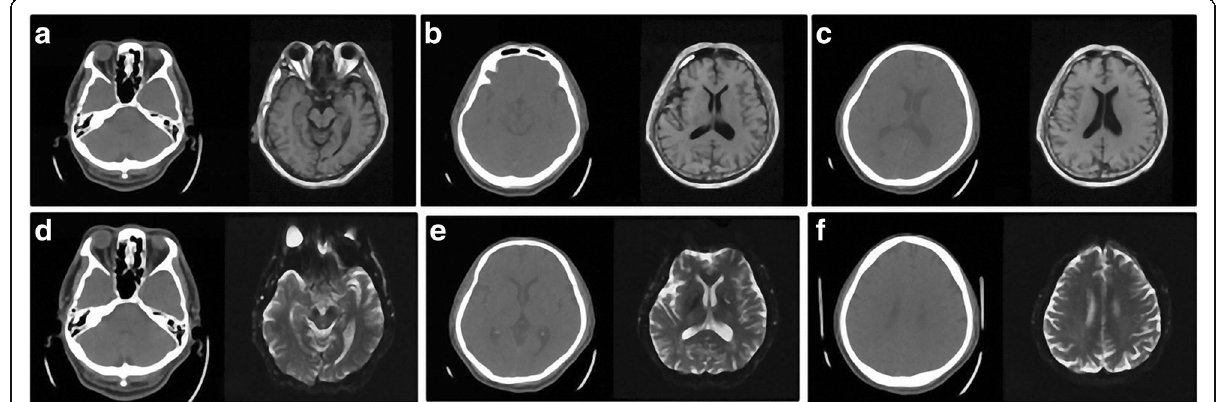
Fig. 3 The registered original images of patient 2. a , b , c are T1-MRI and CT images and d , e , f are DWI-MRI and CT images,